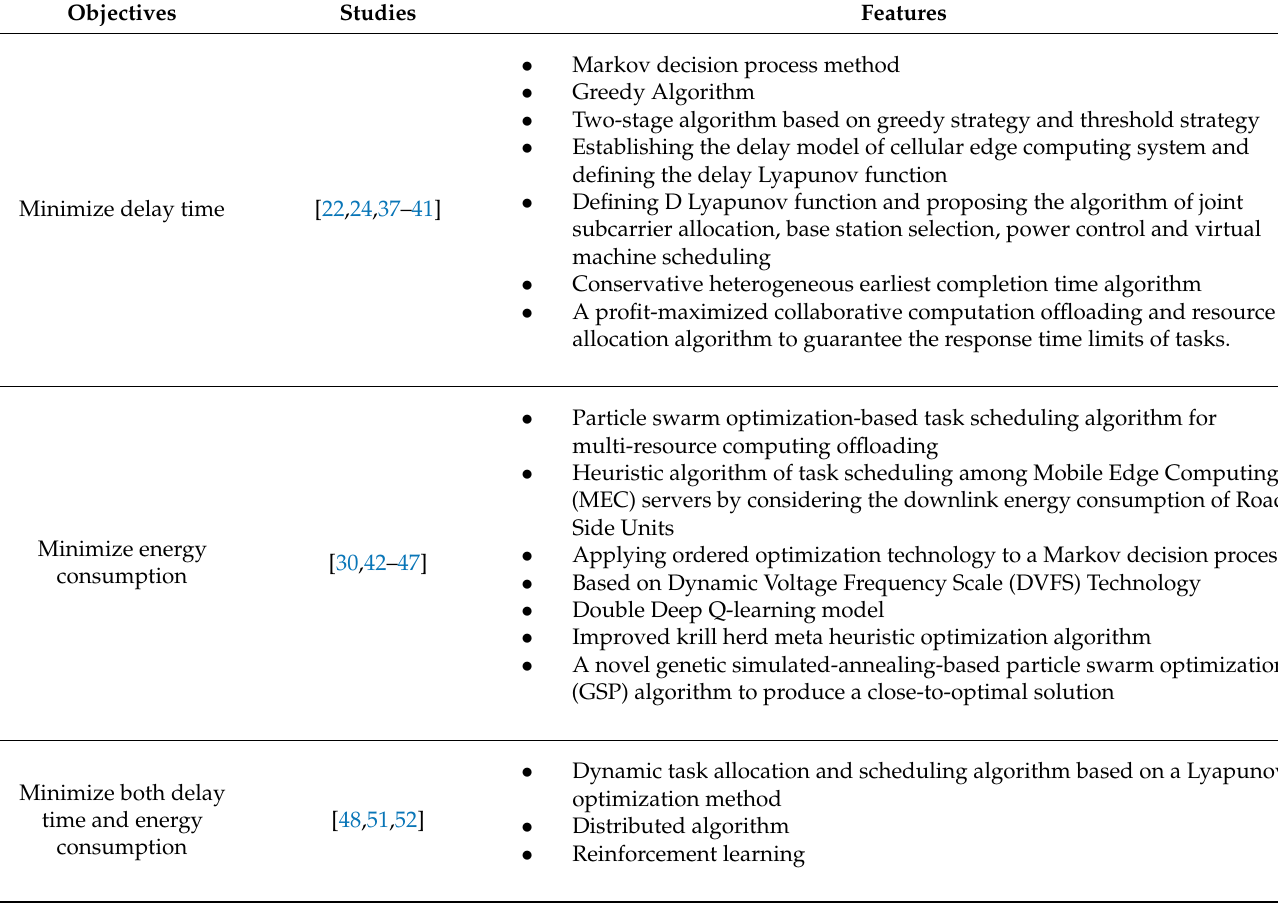
Table 1. Summary of task scheduling